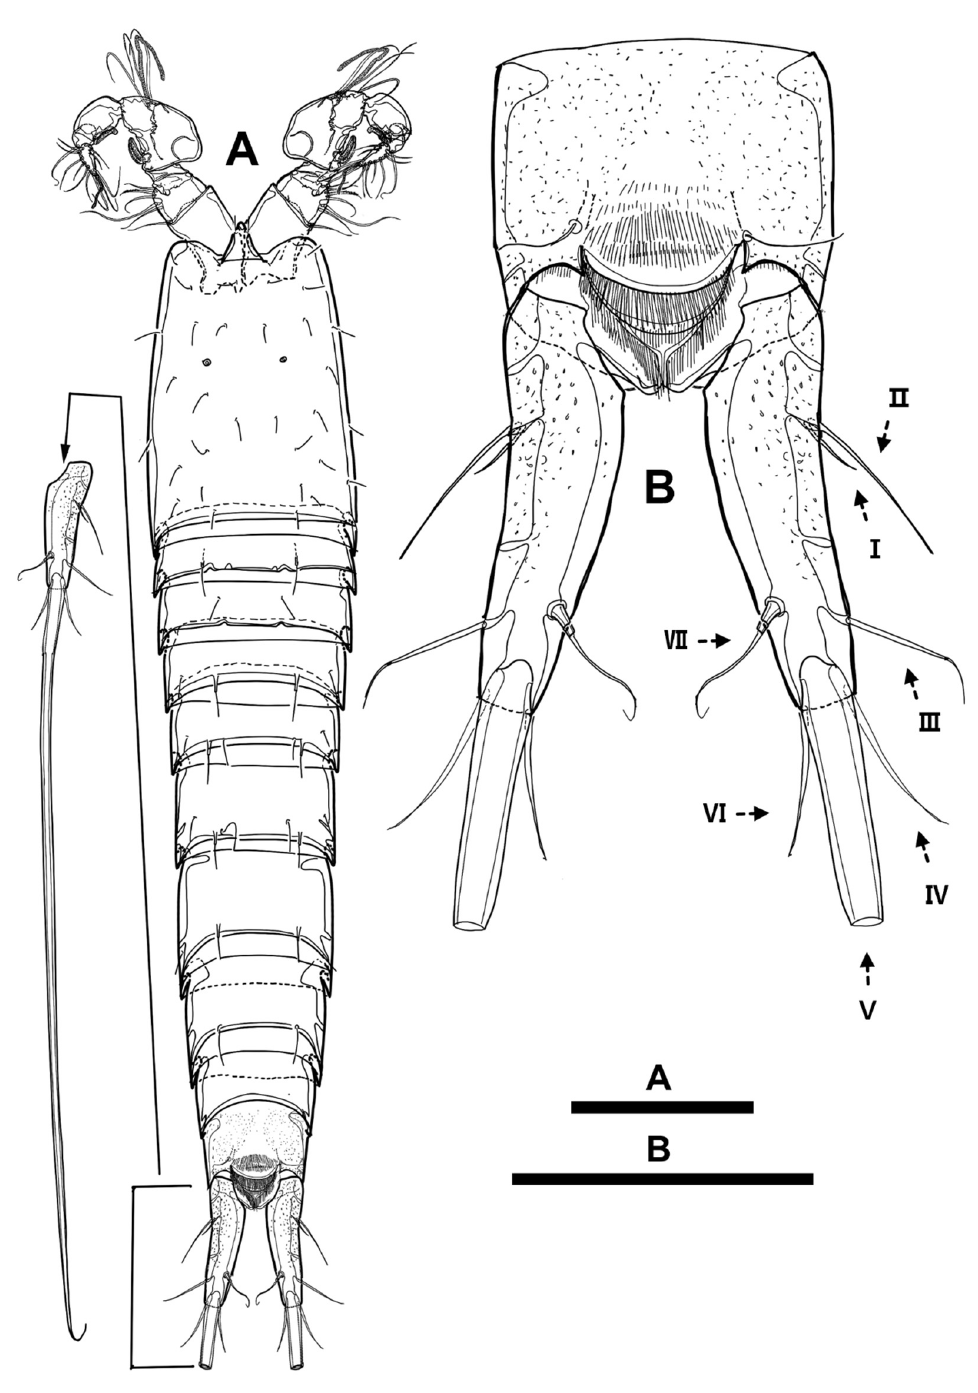
Figure 34. Line drawings of Phyllopodopsyllus similis sp. nov. male (paratype 25): ( A ) habitus, dorsal;